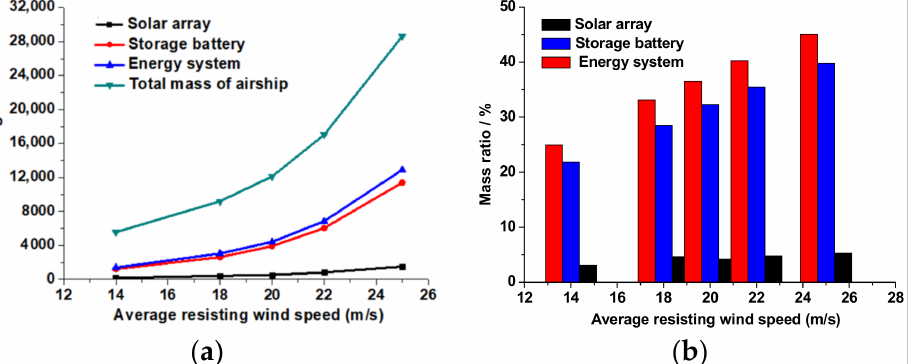
Figure 22. ( a ) The optimized mass of solar array, storage battery, energy system and total mass of airship. ( b ) Optimized mass ratios of solar array, storage battery and energy system for different average resisting wind